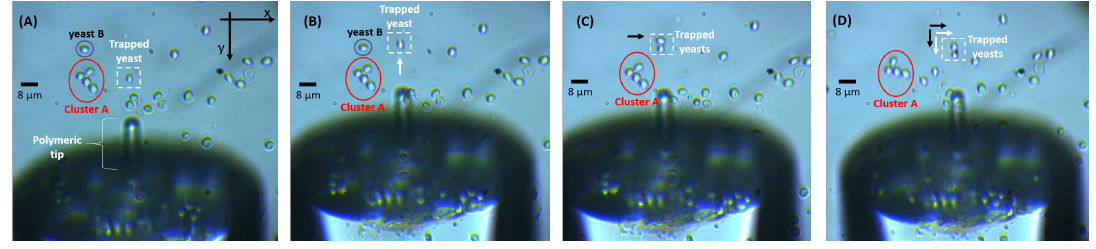
Figure 8. Snapshot sequence showing trapping and manipulation of living yeast cells using the polymeric tip. ( A ) A yeast cell is stably trapped in front of the tip. ( B ) The trapped yeast cell was moved along the − y direction—white arrow—(please consider cluster A as reference). ( C ) Yeast B moves to the right to the position of the polymeric lens beam focal spot (black arrow), being also trapped. ( D ) Both yeast cells are moved to the right ( +x direction) and along the +y direction-white and black arrows by moving the polymeric optical fiber